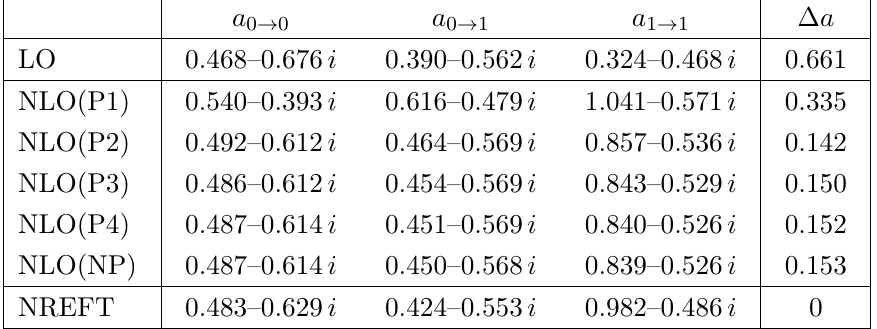
Table 2 . Predictions of ZREFT for complex scattering lengths at the charged-wino-pair threshold. The predictions for (cid:11) = 0 and (cid:14) = 170 MeV at unitarity are made using the parameters in table 1. The scattering lengths are made dimensionless by multiplying them by (cid:1) (cid:3) = 31 : 3 GeV. The row labeled LO gives the predictions at leading order. The rows labeled NLO give the predictions at next-to-leading order using successive perturbative truncations (P1, P2, P3, P4) and using nonperturbative NLO results (NP). The last row labeled NREFT gives the actual scattering lengths calculated using NREFT. The last column labeled (cid:1) a gives the square root of the sum of the squares of the